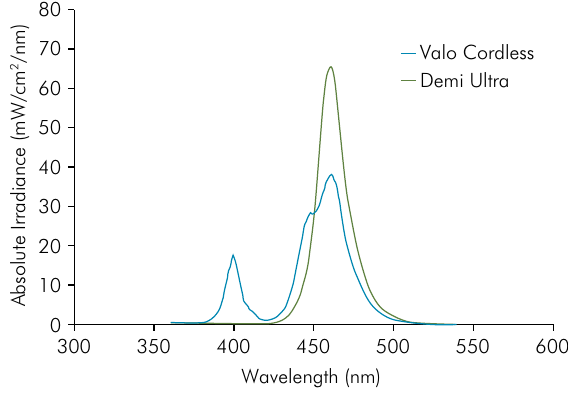
Figure 1. Emission spectra of Valo (blue line) and Demi Ultra (green line)